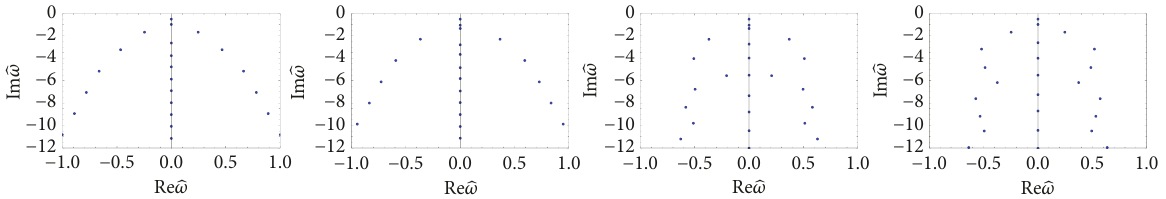
Figure 25: QNMs (blue spots) of the gauge mode for |𝛾 2 | = 1/24 (the first two panels are for 𝛾 2 = −1/24 and the second two panels for 𝛾 = 1/24 ) and ̂𝛼 = 2/√3 . The first and third panels are the QNMs of the gauge mode and the second and forth panels are that of the dual 2 gauge